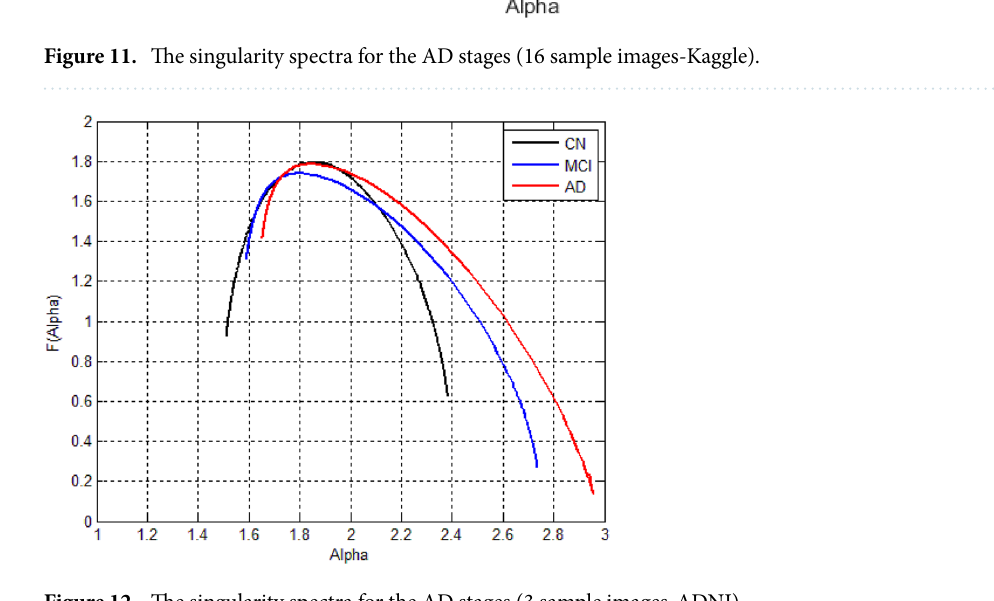
Figure 12. The singularity spectra for the AD stages (3 sample images-ADNI).